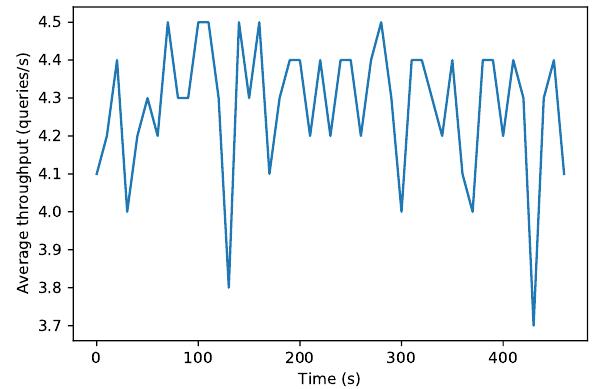
Figure 12. Performance of the fog OrbitDB node executing 2000